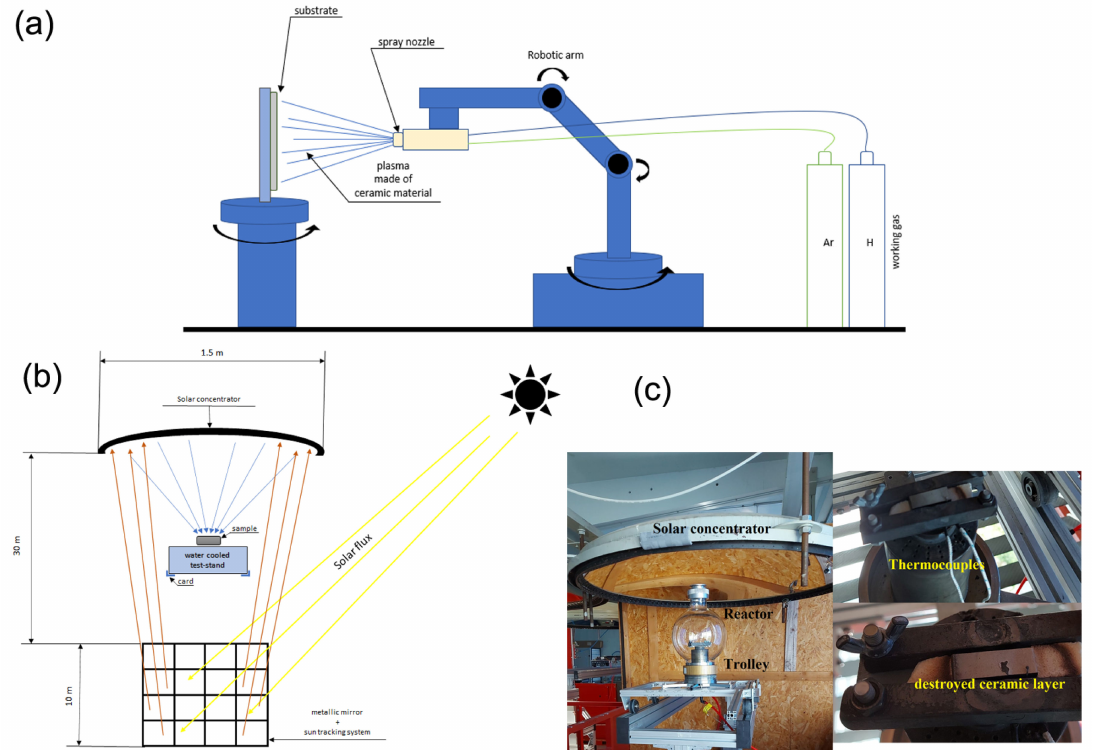
Figure 1. Robotized arm for atmospheric plasma spraying deposition (APS) in ( a ) and the thermal shock set-up in ( b , c